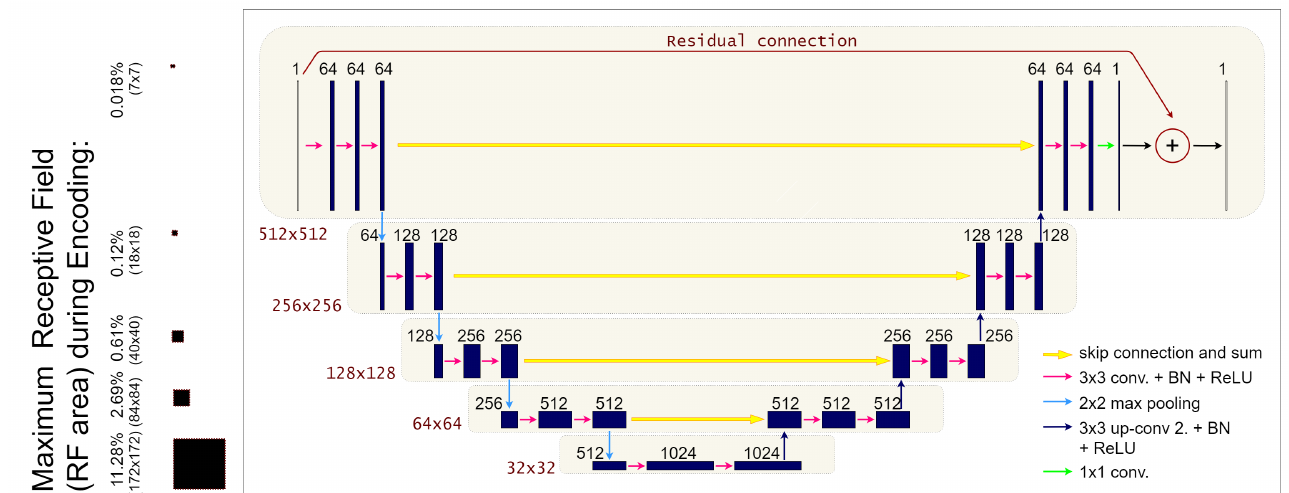
Figure 3. On the right: graphical representation of the ResUNet architecture; On the left: details on the maximum receptive fields for each of the five levels of the network encoder (RF percentage respect to the input 512 × 512 image and size of RF).